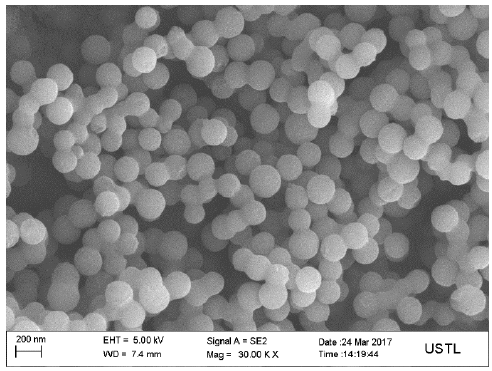
Figure 3. Scanning electron microscopy (SEM) images of the carbon microspheres (×30,000).